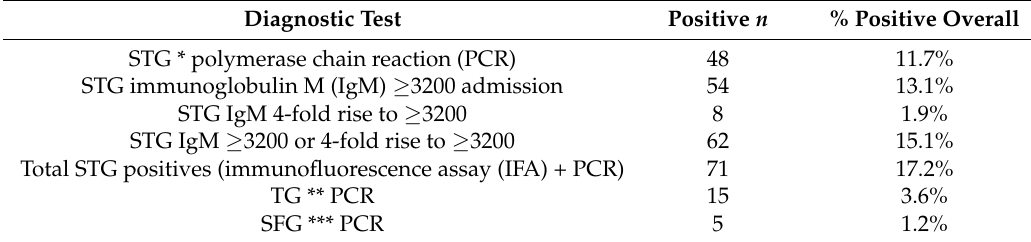
Table 1. Patient and diagnostic characteristics.